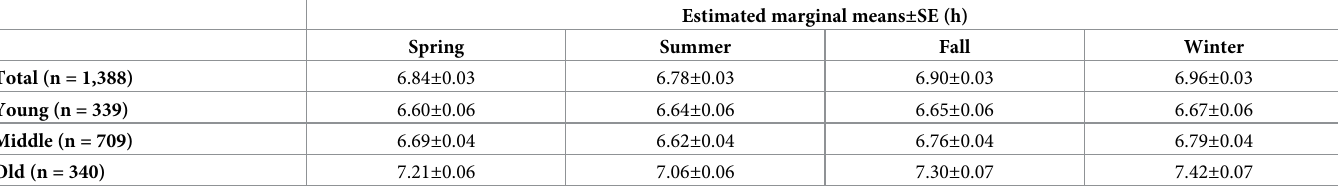
age group slept longer in winter than in spring (p = 0.038) and summer (p < 0.0001), and in fall than in summer (p < 0.001). No significant differences in sleep duration among seasons were found in the young age group, meaning that their sleep duration was not seasonally changed. groups were 0.36 ± 0.05 h and 0.17 ± 0.03 h, respectively. 2B. Men slept shorter in summer than in fall (p = 0.001) and winter (p = 0.003). Women slept